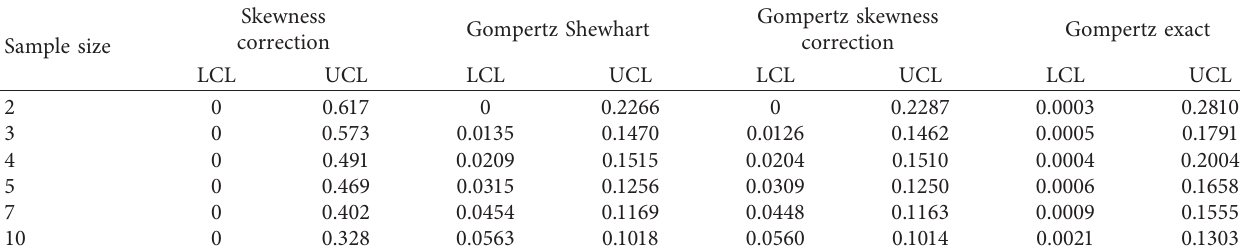
Table 1: Control limits for skewness correction, Gompertz Shewhart, Gompertz skewness correction, and Gompertz exact control charts.